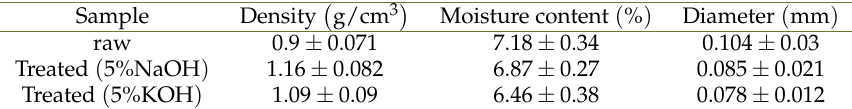
Table 2. Raw and alkali-treated PFs’ density, moisture content, and diameter.